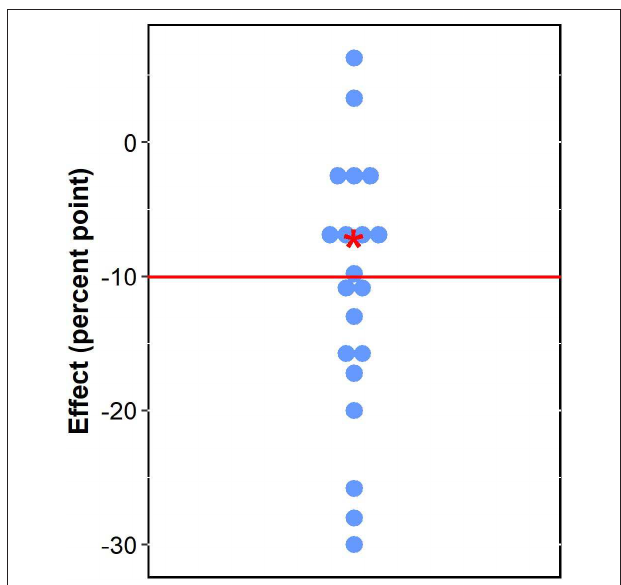
FIGURE 3 | Effects of forests and nutrition interventions on child stunting (red star: conservative effect of forests; blue circles: effects of interventions reviewed in Hossain et al., 2017; red line: median of blue